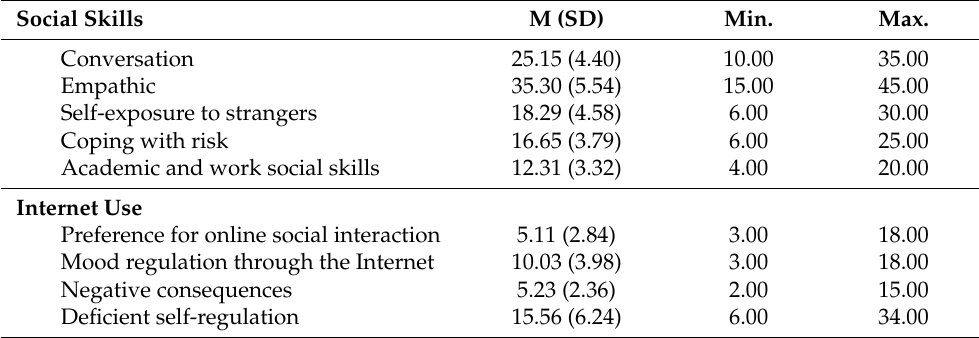
Table 1. Descriptive data on social skills (Independent variable) and internet use (Dependent variable). Social Skills M (SD)